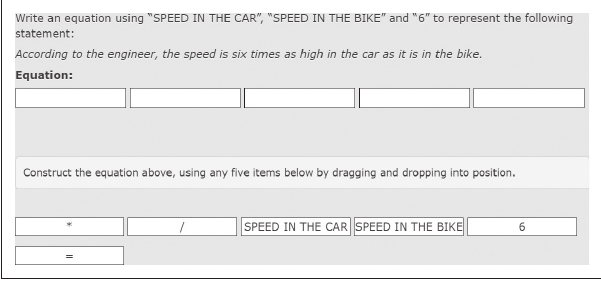
FIGURE 1: Example of a word problem appearing on the learning management